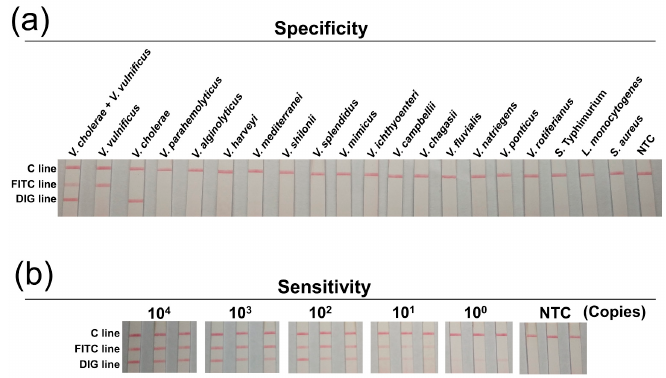
Figure 4. Specificity and sensitivity of the duplex RPA-LFS biosensor. ( a ) Specificity of the biosensor. Templates used for testing were indicated on top of each strip. The DNA concentrations of the templates were normalized to 10 ng/ μ L and 1 μ L was used for each reaction. The image represented results from three independent experiments. ( b ) Sensitivity of the biosensor. Mixed templates (double template of V. vulnificus and V. cholerae ) of different amounts were used for testing. The amount (in copies) was shown at the top of the strips. The triplicate strips represented results from three independent experiments. The NTC strips were the no-template controls.